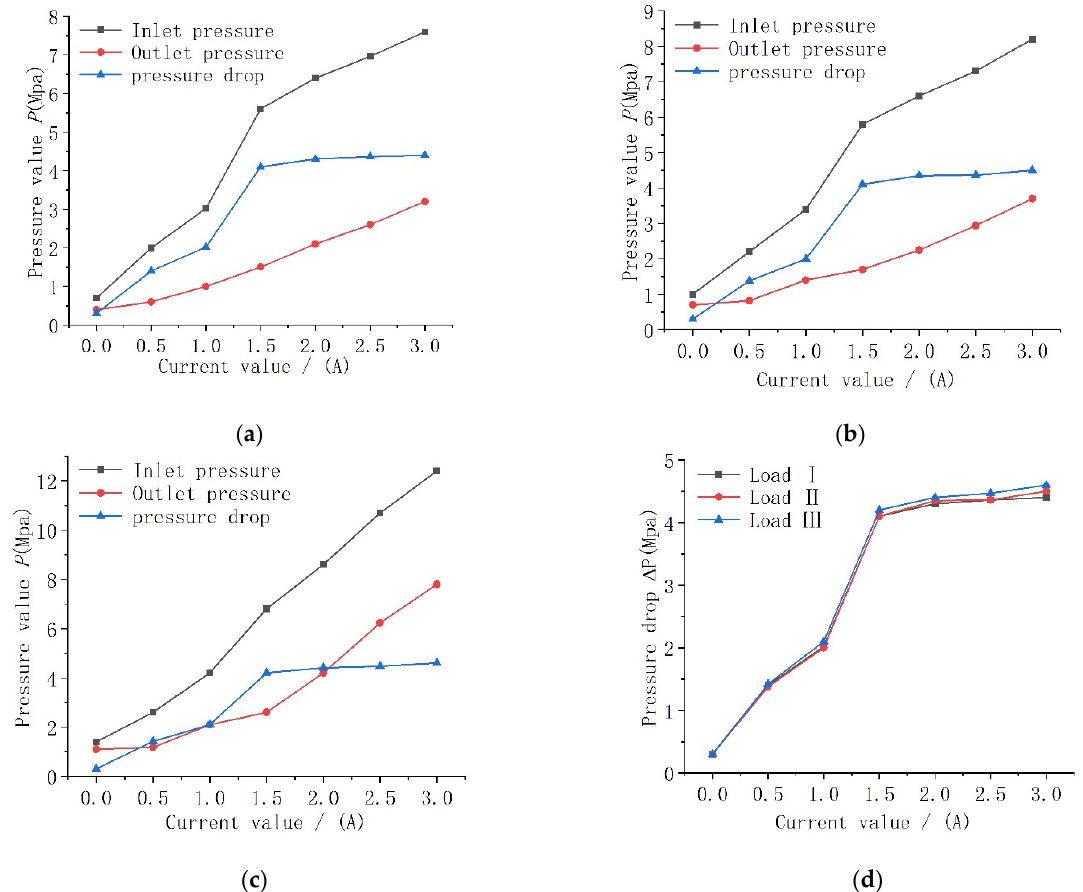
Figure 12. ( a ) Pressure variation diagram of load 1. ( b ) Pressure change diagram of load 2. ( c ) Pressure change diagram of load 3. ( d ) Influence of different loads on the performance of annular multi-channel MR valve.